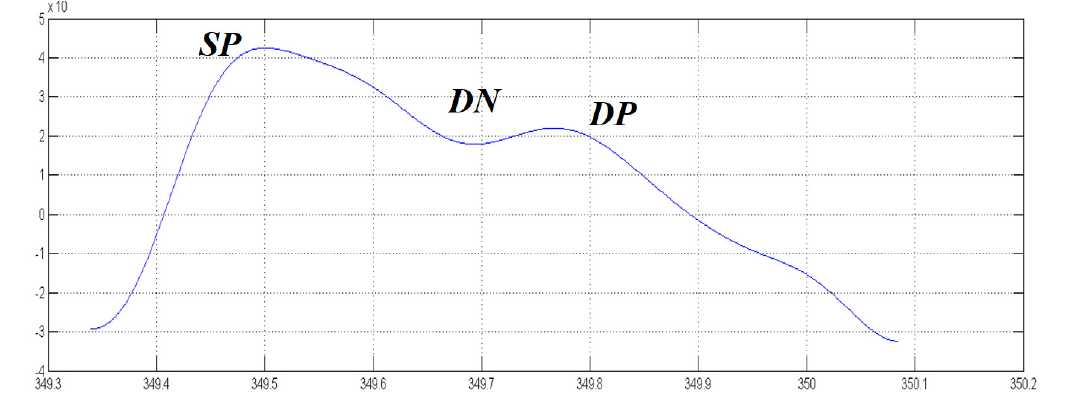
Figure 1. A compliant standard PPG waveform. The different signal components are detailed: Systolic Peak (SP), Dicrotic Notch (DN) and Diastolic Peak